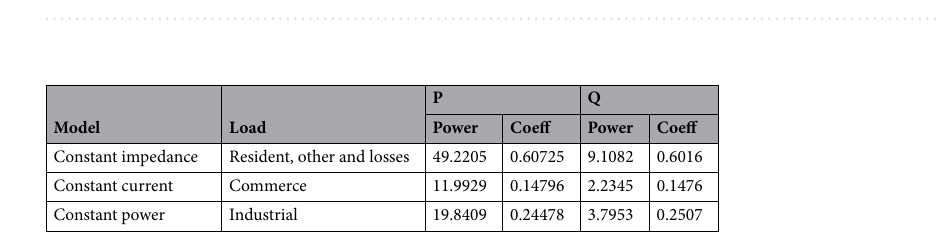
Table 2. Changes in magnitude and angle before (left) and after (right) the Policentro static load model.